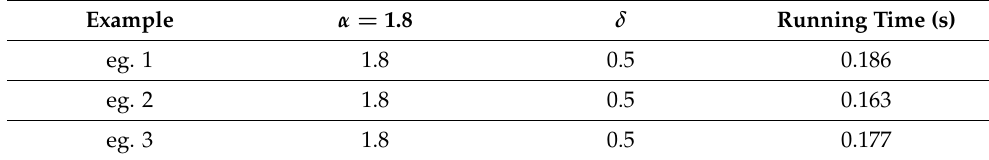
Table 4. Running times of Example 1, Example 2, and Example